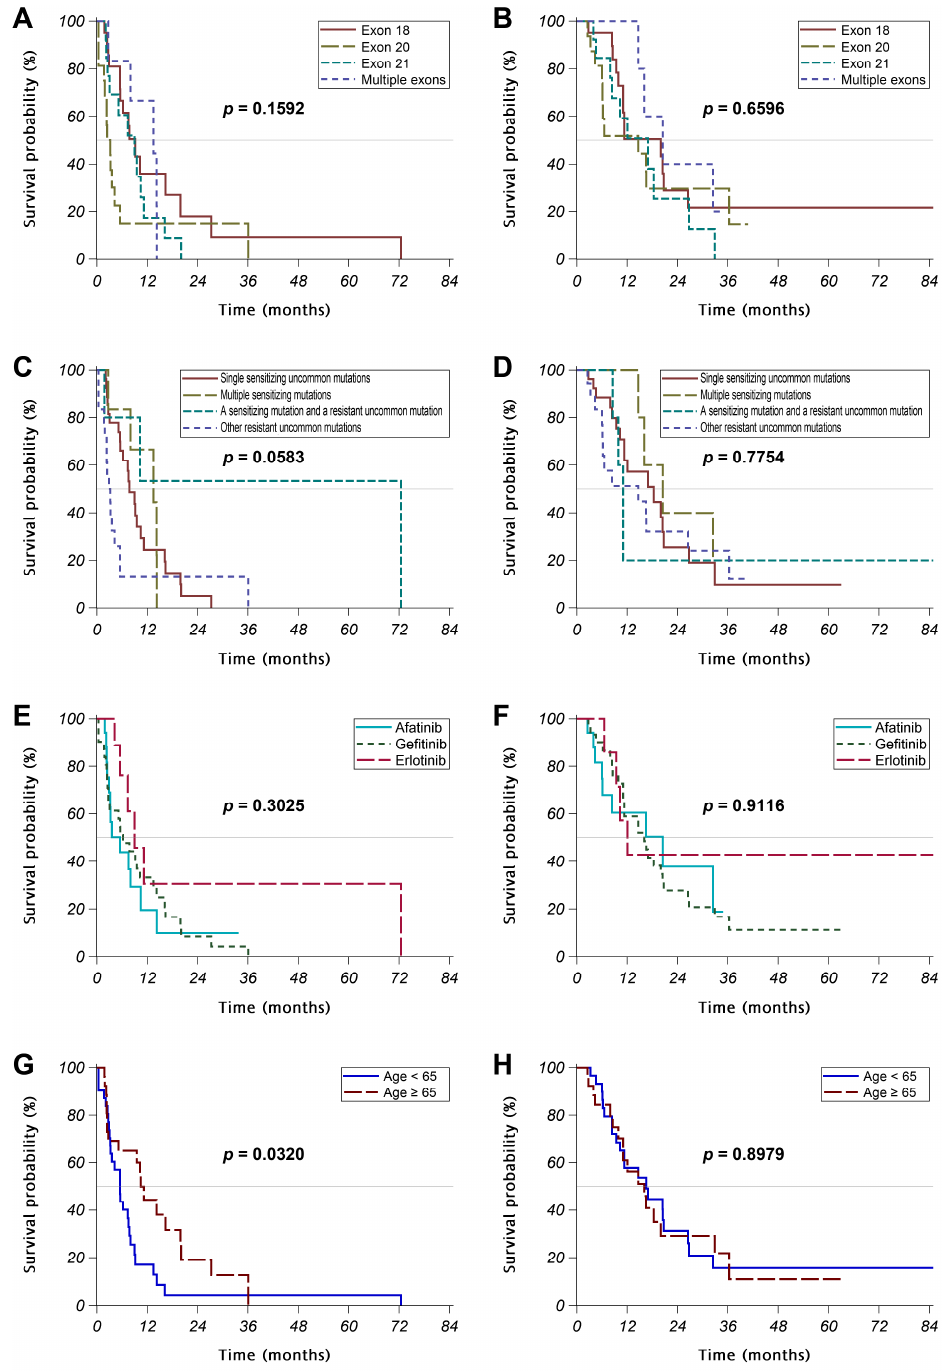
Figure 1. Kaplan-Meier curves of the progression-free survival (PFS) ( A , C , E , G ) and overall survival (OS) ( B , D , F , H ) of the patients receiving a first-line EGFR TKI, while classified the patients by ( A , B ) the exon of EGFR mutation, ( C , D ) the drug sensitivity of EGFR mutation, ( E , F ) the EGFR TKI used, and ( G , H ) the age group. Abbreviation: PFS = progression-free survival; OS = overall survival.